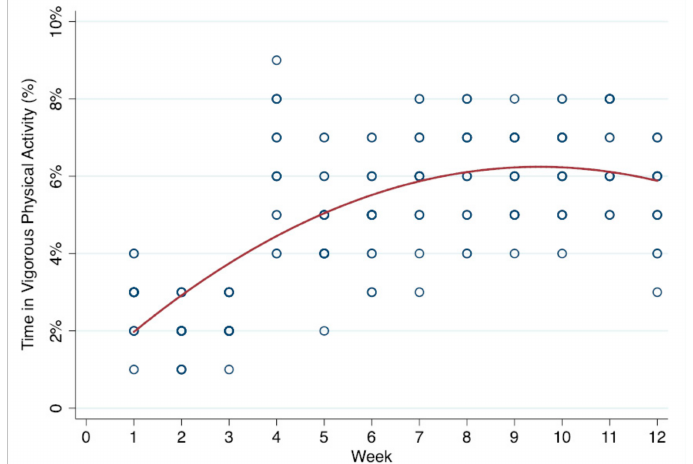
Figure 1. Quadratic time trend for sedentary behavior (%) across weeks.